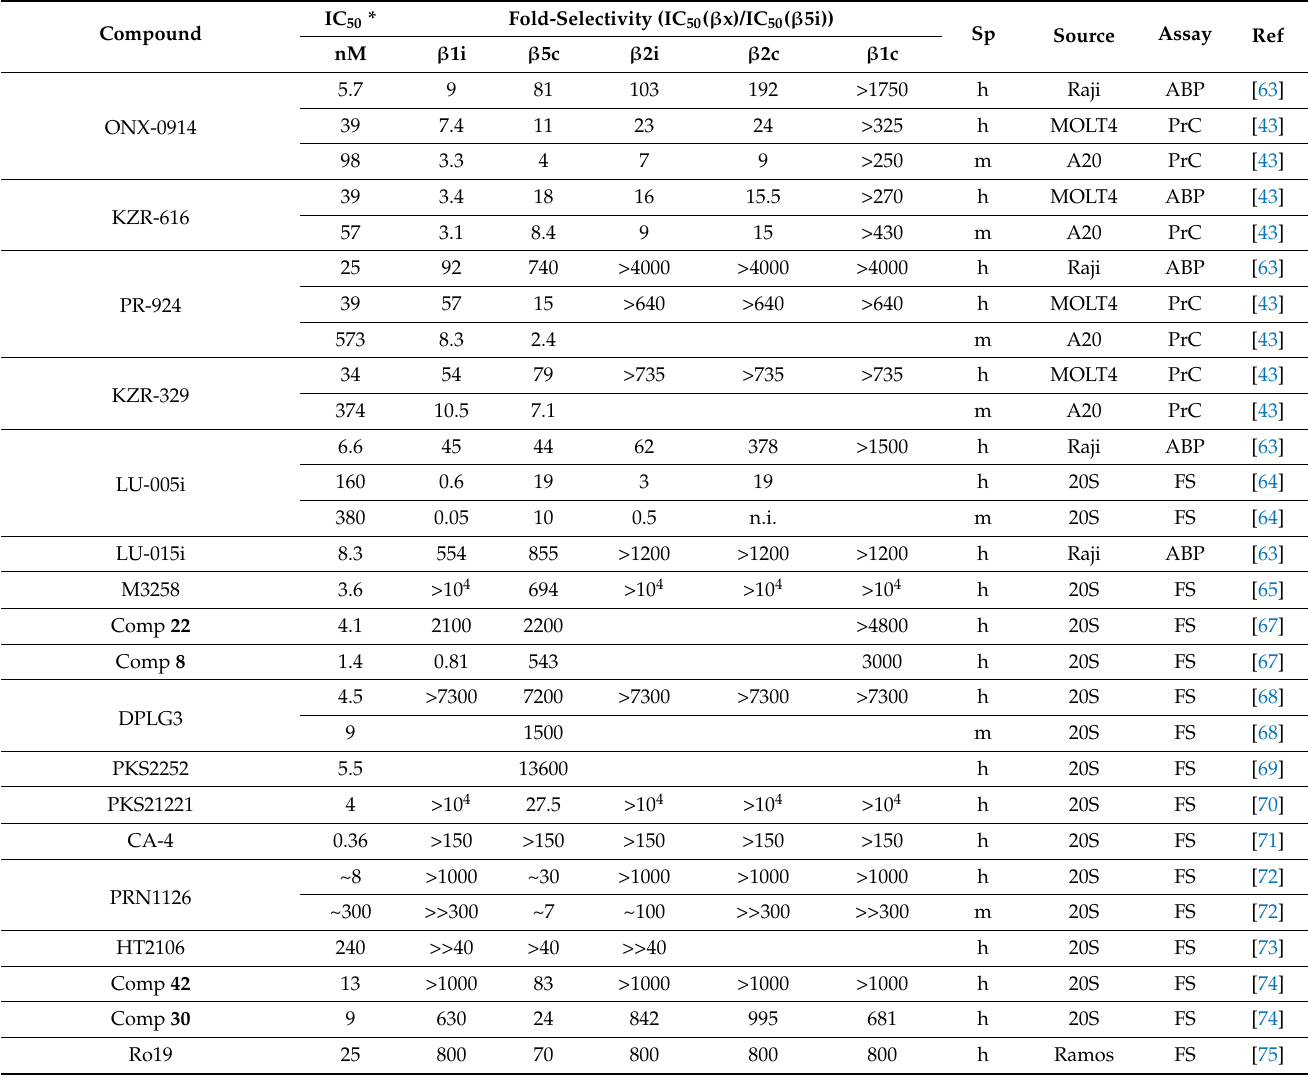
Figure 5. Boronate β 5i inhibitors. The commercially available compound is in bold. Table 3. β 5i inhibitors.